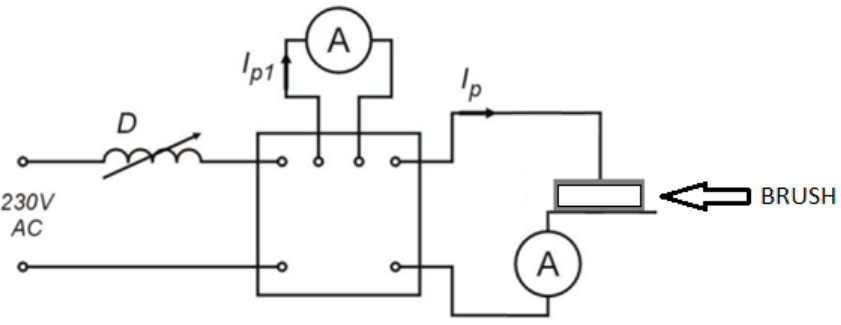
Figure 5. The connection scheme of the setup.